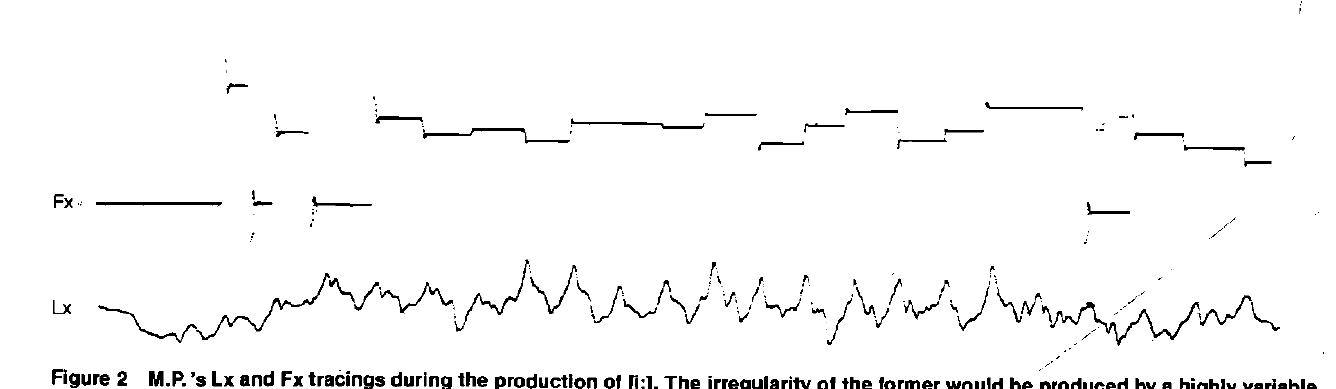
Figure 2 M.P. 's Lx and Fx tracings during the production of [i:]. The irregularity of the former would be produced by a highly variable vibratory source. The lack of smoothness of the Fx trace reflects